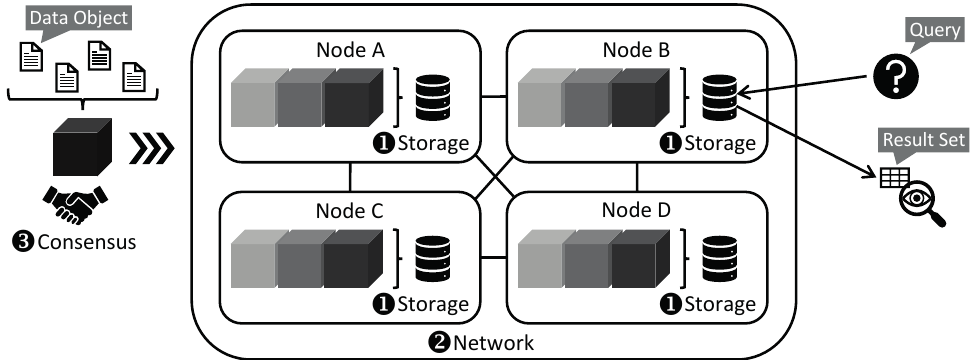
Figure 1. Simplified architecture of a blockchain system with its three layers: (cid:202) Storage, (cid:203) Network, and (cid:204)